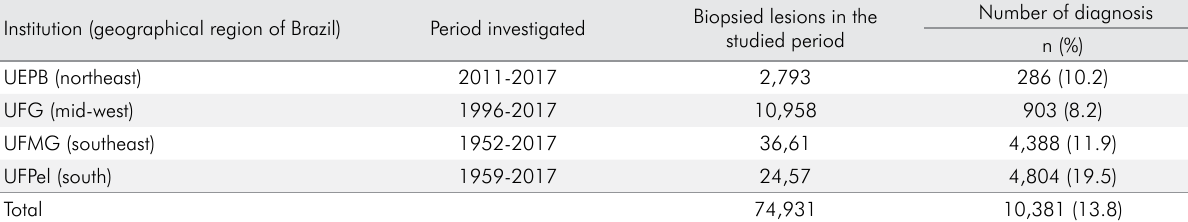
Table 1. Frequency of chronic inflammatory periapical diseases. Institution (geographical region of Brazil) Period investigated